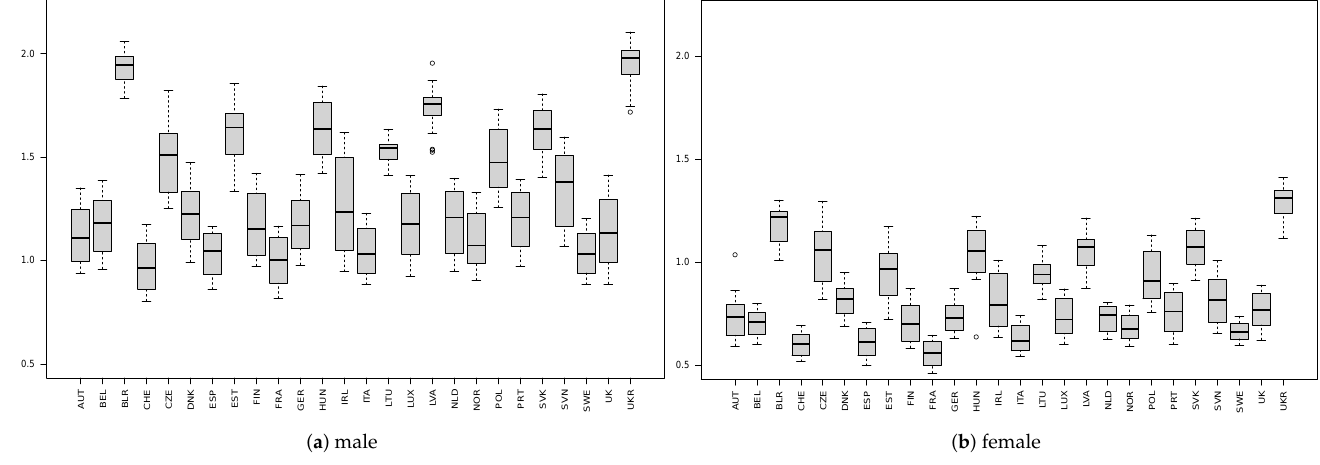
Figure 3. CMF variability in Europe for males and